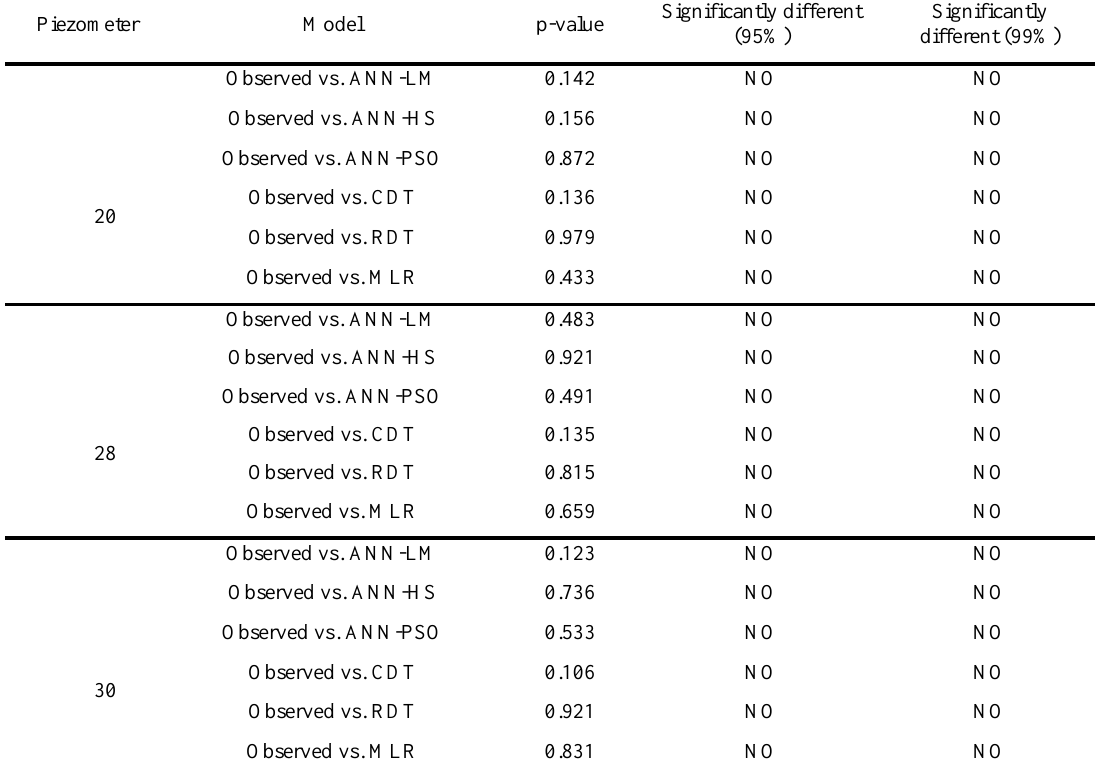
Table 7- Statistical investigation of results obtained via Man-Whitney method